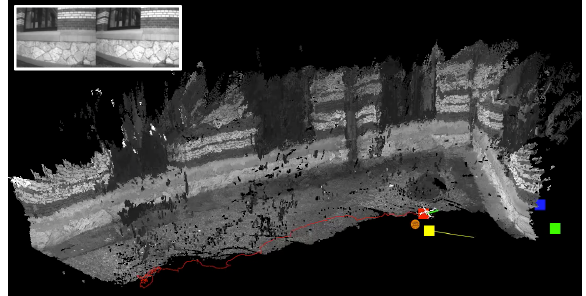
Figure 13: Real-time and online 3D reconstruction from a fully autonomous flight where the quadrotor followed the wall to cap- ture the building. The yellow ball is calculated based on the cur- rent depthmap and indicates the next position the system should fly to.